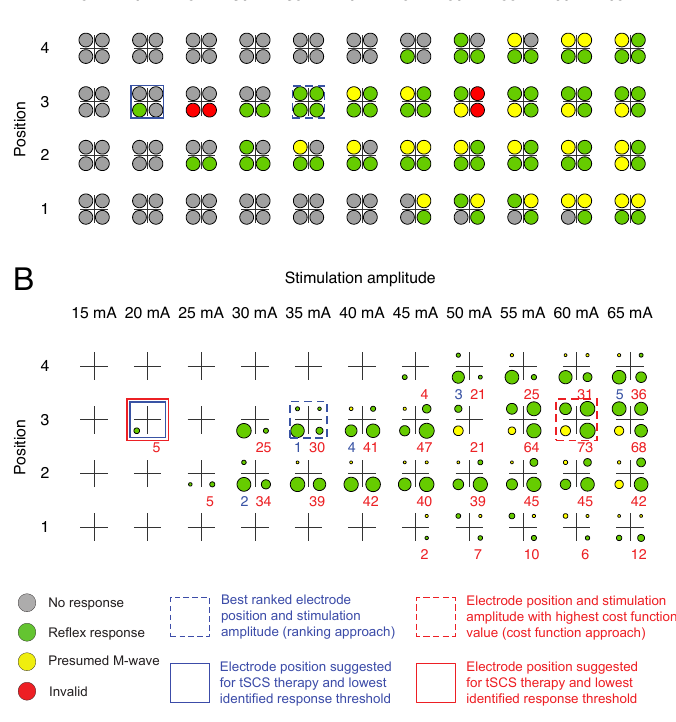
Figure 5. Comparison of ranking based on the two automatic response evaluation approaches applied. ( A ) Rating light matrix and ( B ) rating details matrix derived for participant S2 with SCI. Both approaches resulted in the suggestion of electrode position 3 and identified 20mA as the lowest response threshold. The four color-coded circles represent the results obtained for the four muscle groups studied (cf. Table 2). In the rating details matrix, the cycle size additionally provides information on the attainable response sizes. If no response had been elicited, the circle shrank to a dot. Blue numbers are ranks 1–5 as derived from the ranking approach, and red numbers are cost function values J calculated in the cost function approach, with higher values signifying favorable